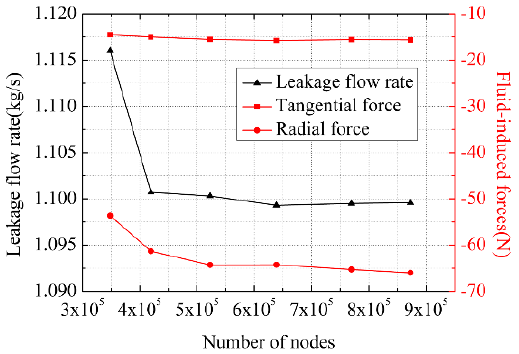
Figure 11. Mesh independence study of leakage and fluid-induced forces.